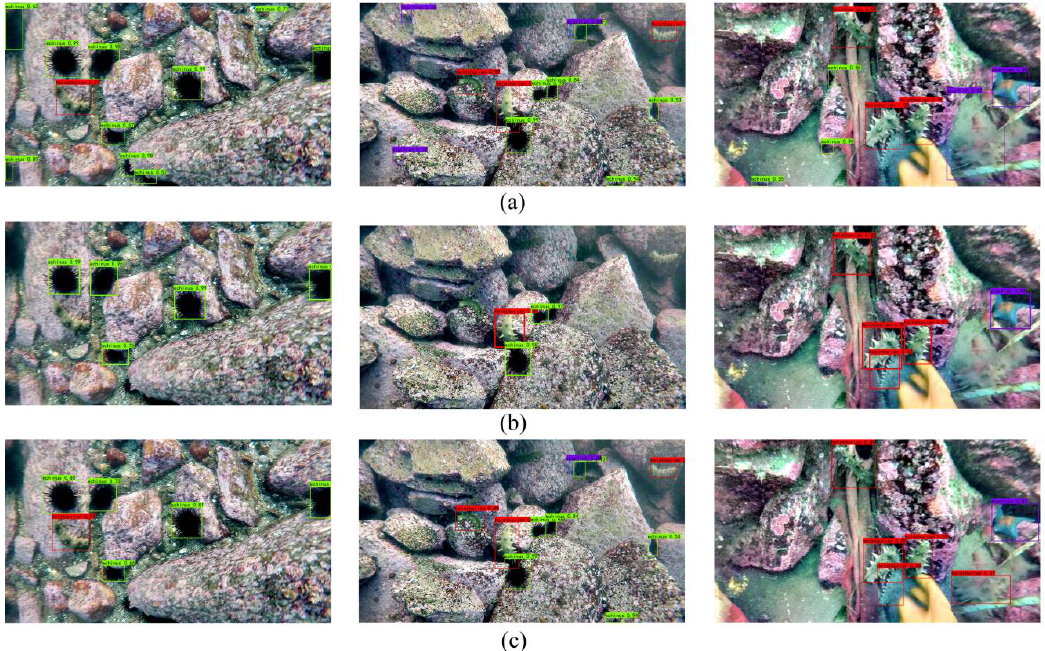
Figure 11. Detection results of different detection algorithms on the proposed dataset. ( a ) Faster- RCNN test results, ( b ) YOLOV3-Tiny test results, and ( c ) YOLOV4-Tinier test